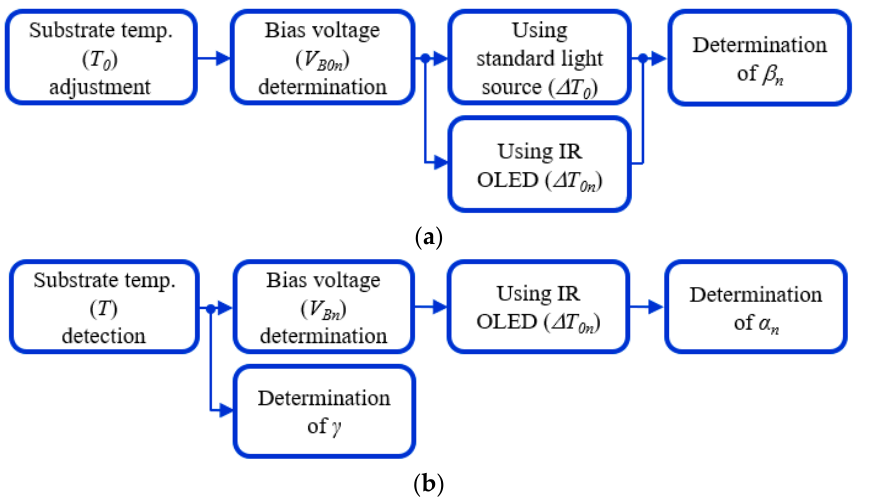
Figure 3. Calibration sequence of the proposed NUC method: ( a ) calibration in the production phase; ( b ) start-up calibration.